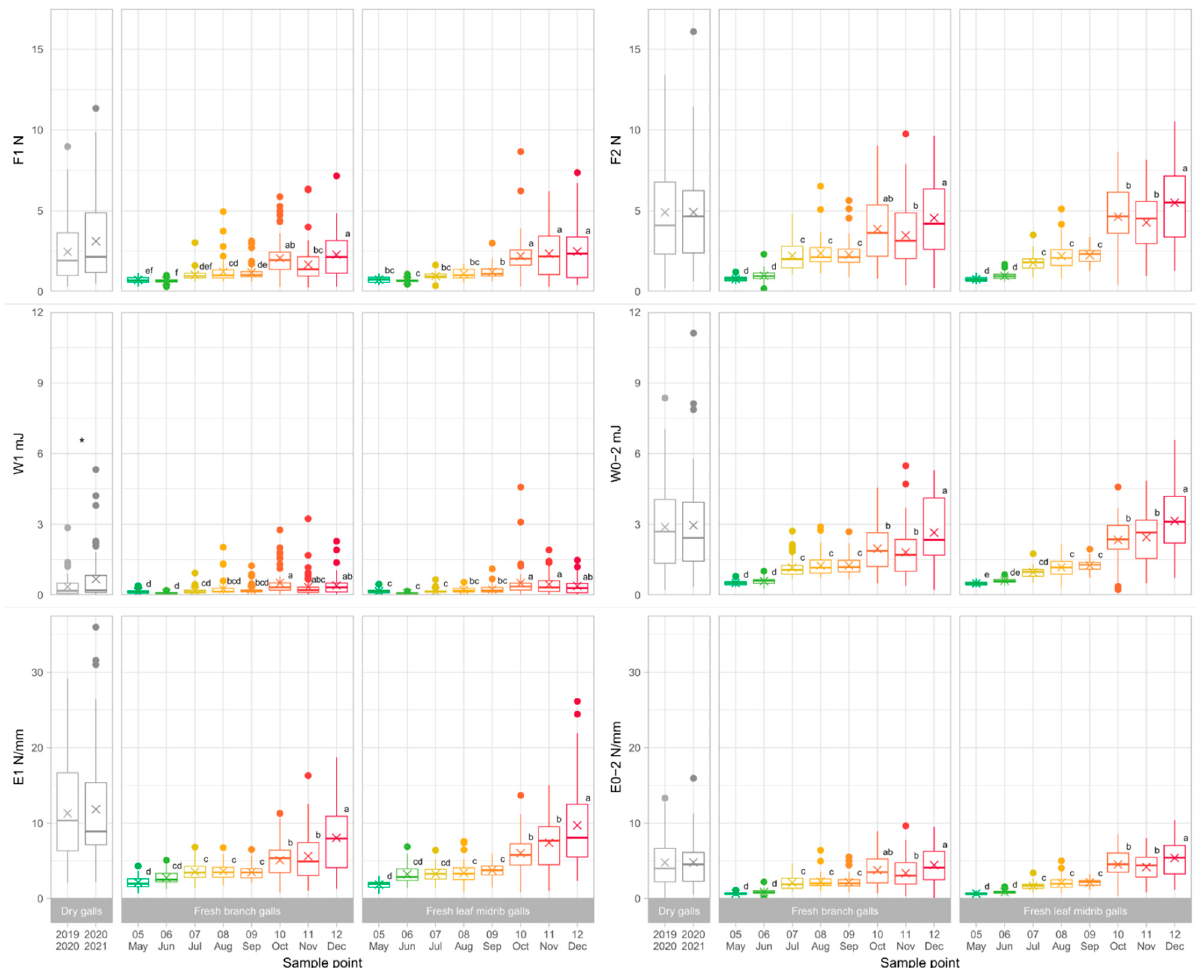
Figure 3. Evaluation of mechanical parameters on dry and fresh galls using a 1-mm needle compression test, distinguishing between fresh branch and leaf midrib galls (N = 60). The multiplication sign ( ✕ ) represents the mean value for each sample. Outliers were represented with colored points. Inside each parameter and sample type (dry galls, fresh branch galls, fresh leaf midrib galls), different letters evidence significant difference at p < 0.05 (Tukey HSD post-hoc test).